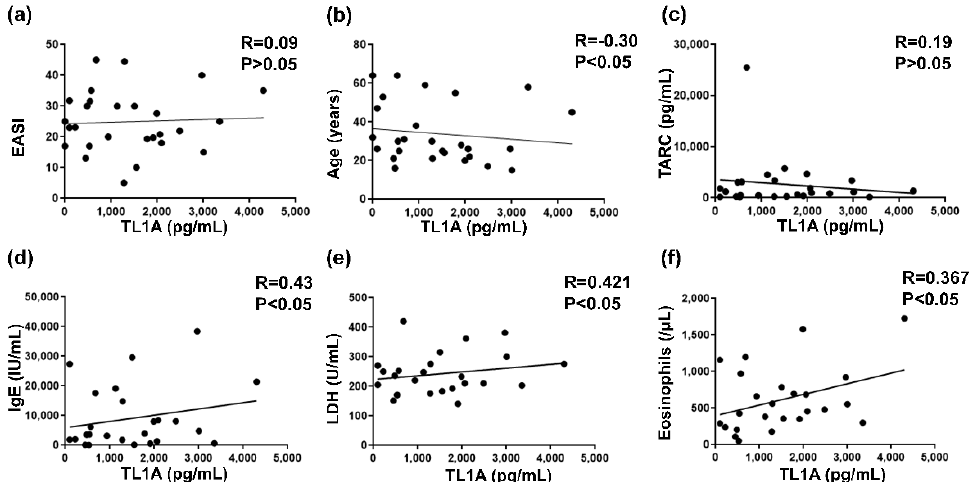
Figure 2. Correlation between TL1A protein levels and clinical markers in TL1A positive patients of AD. ( a ) Correlation between serum TL1A protein levels and Eczema Area and Severity Index (EASI). ( b ) Correlation between serum TL1A levels and the age of each patient. ( c ) Correlation between serum TL1A levels and serum thymus and activation-regulated chemokine (TARC) levels. ( d ) Correlation between serum TL1A levels and serum immunoglobulin E (IgE) levels. ( e ) Correlation between serum TL1A levels and serum lactate dehydrogenase (LDH) levels. ( f ) Correlation between serum TL1A levels and the number of eosinophils in peripheral blood.